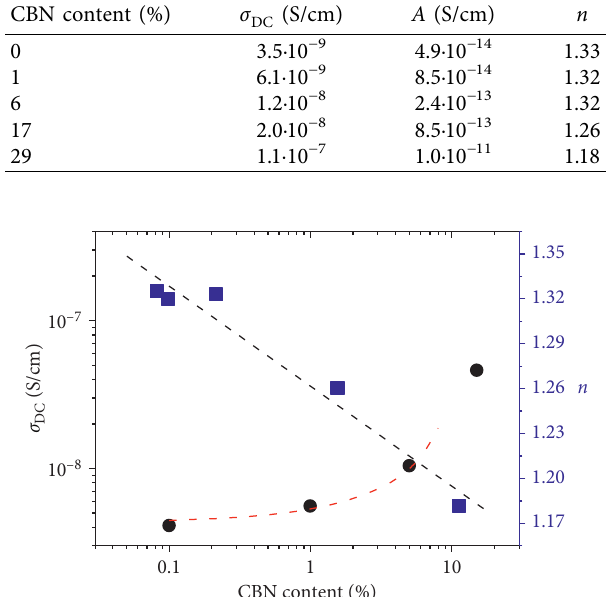
Figure 2: Direct current conductivity and interaction parameter vs. concentration for epoxy- and CBN-based systems. The dotted red line is the percolation model (equation